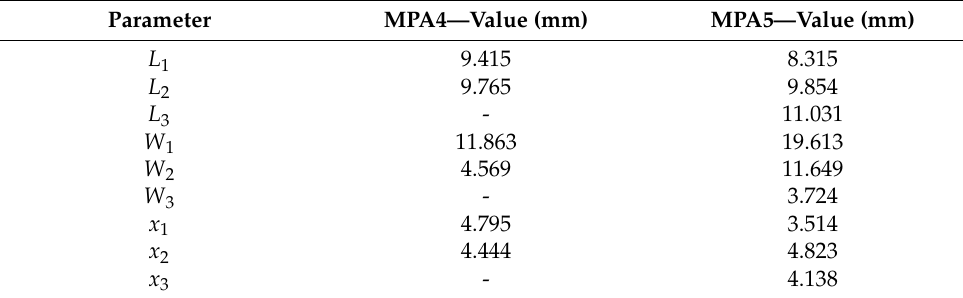
Table 3. MPA4 and MPA5 geometrical parameters.